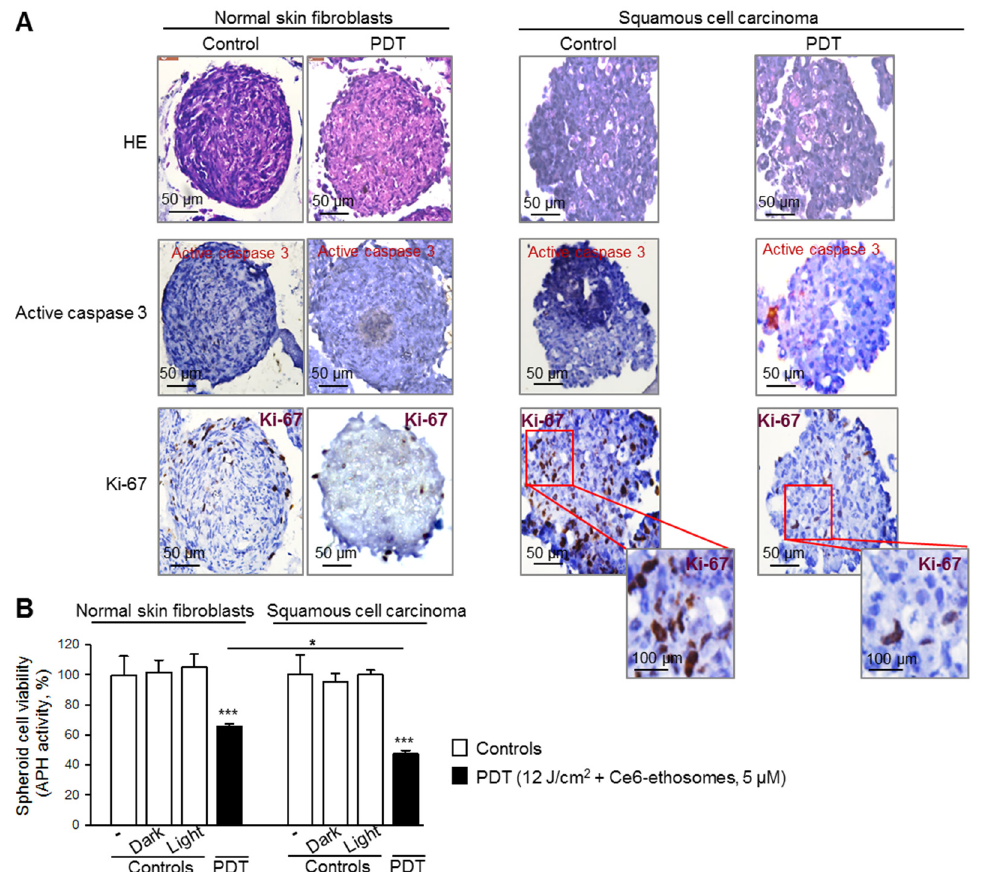
Figure 5. Comparison of PDT effect of Ce6 ethosomes on 3D cultures of normal skin fibroblasts and squamous cell carcinoma. Five-day spheroids were either untreated or PDT-treated (5 µM Ce6 ethosomes for 24 h, then treatment with 12 J/cm 2 light dose, followed by analysis after 24 h). Controls: spheroids only, including dark control (spheroids treated for 48 h with 5 µM Ce6 ethosomes) and light control (spheroids treated with 12 J/cm 2 light dose only, analyzed 24 h later). ( A ) Spheroids were fixed, embedded, and cut into 3 µm slices. Staining with antibodies against active caspase 3 indicated induction of apoptosis (red cellular stain); staining with anti-Ki-67 showed proliferating cells (brown nuclear stain); HE, hematoxylin, and eosin. The original magnification was 40x. ( B ) Cell viability was evaluated by analysis of activity of cytosolic acid phosphatases. Data are mean ± SD; n = 3, * p < 0.05 fibroblasts vs. squamous cell carcinoma, *** p < 0.001 vs. respective controls.